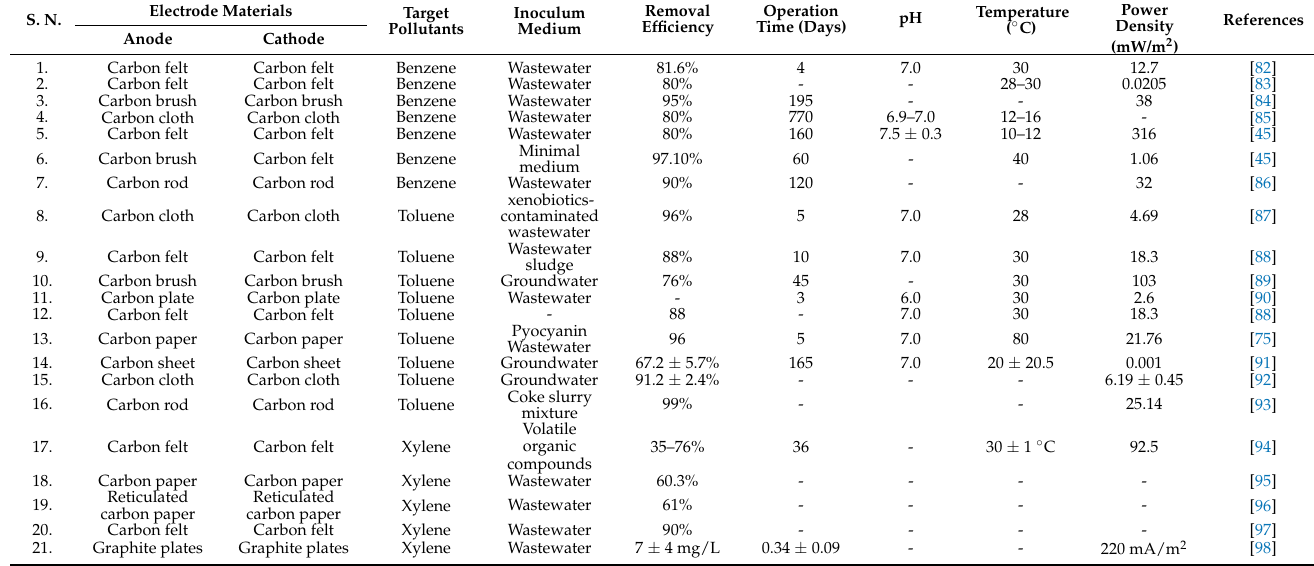
Table 1. Summary of numerous studies on BMFCs for removal of BTX with production of energy. S.